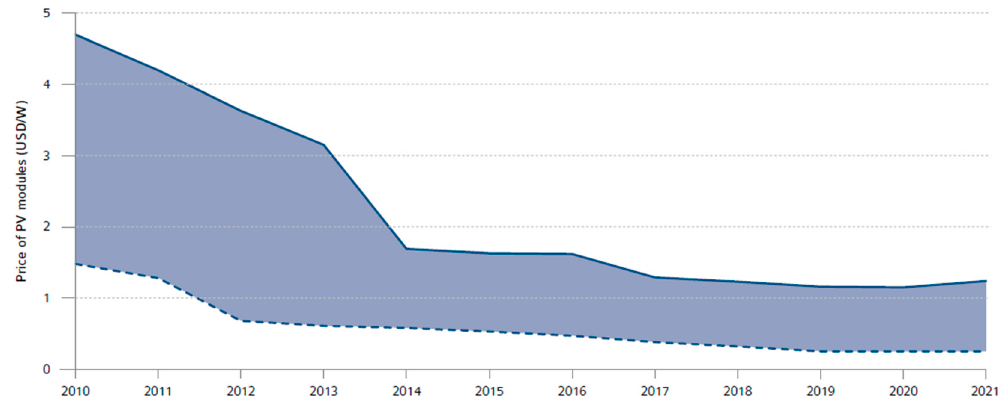
Figure 5. Evolution of PV module prices [22].